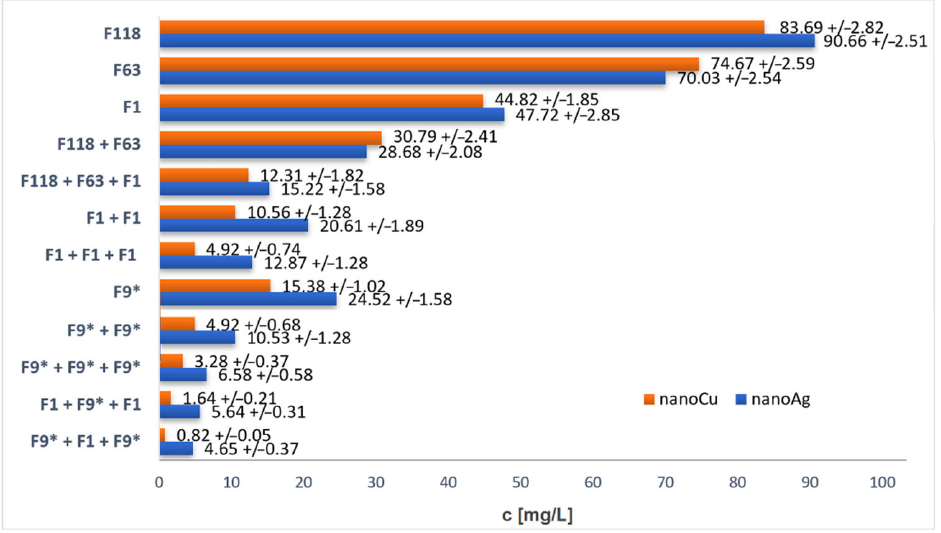
Figure 4. Change in concentration of acceptor fluid after nanoparticle diffusion depending on the filter used. As can be seen from the analysis of the data in Figure 5, the largest quantity of parti ‐ cles entered the acceptor fluid through the 118 μ m mesh size filter. However, for a filter with a mesh size almost a half smaller (63 μ m), the concentration of nanoparticles did not decrease by half but only by more than 20%. When a single filter with a mesh size of 1 μ m was used, relatively large results were also obtained, considering that the mesh size was reduced by as much as 118 times compared to the F118 filter, the concentration of